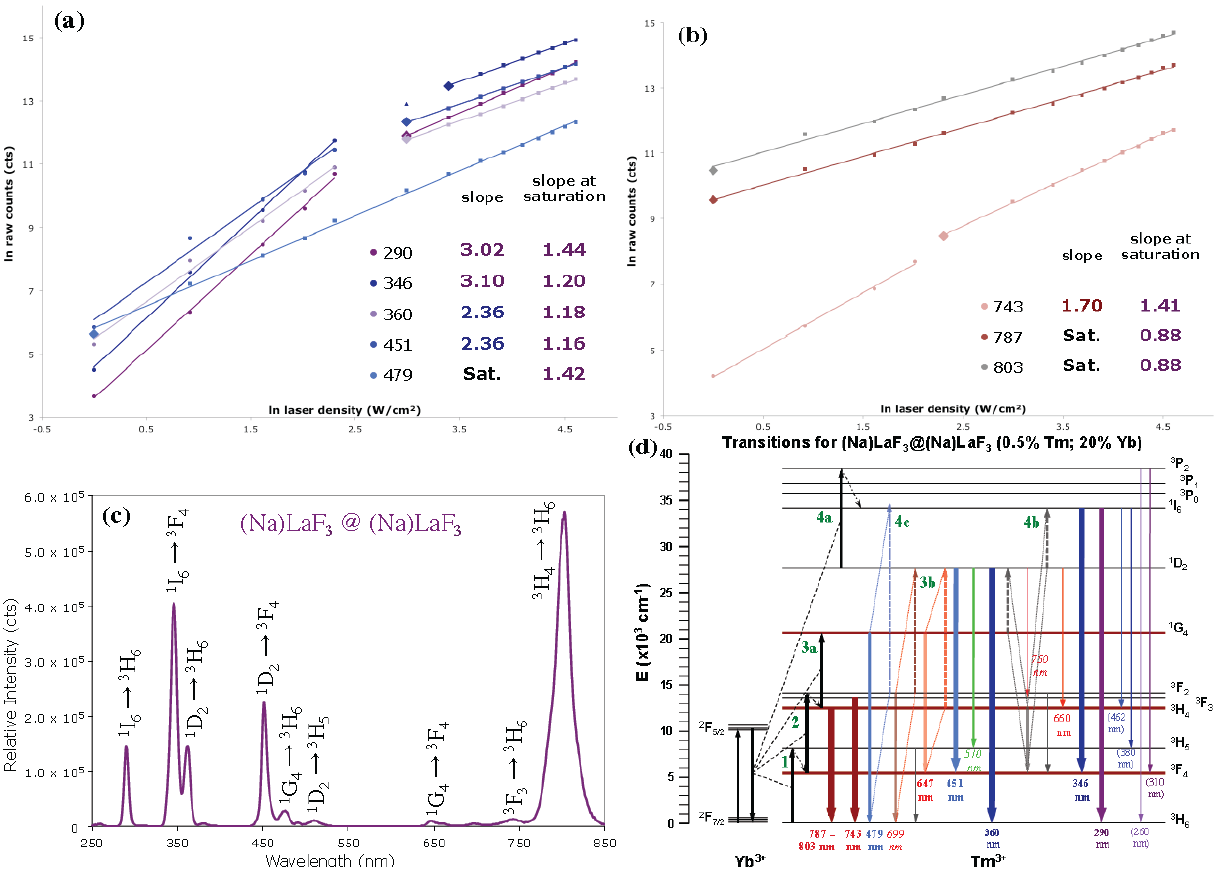
Figure 6. Emission intensity vs . 980 nm laser power density (W/cm 2 ), expressed in ln-ln IvP plots of 0.5% Tm, 20% Yb codoped (Na)LaF ( b ) NIR regimes, noting low power saturation of Tm 3+ 3 H (diamond markers); ( c ) Emission spectrum recorded at 20 W/cm 2 and ( d ) ETU transition diagram of Yb 3+ -Tm 3+ . Experimental conditions: 1 mg/mL solutions in toluene at 23 °C; 980 nm CW laser excitation varying from 2.5 to 100 W/cm 2